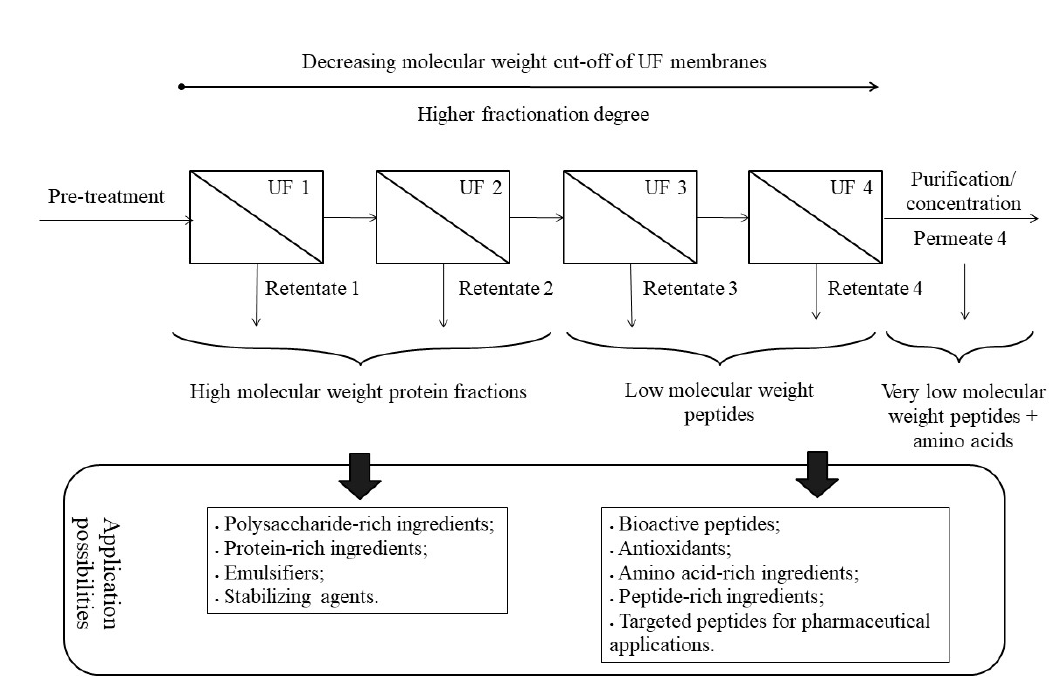
Figure 2. Ultrafiltration (UF) fractionation cascades for the recovery of several protein and peptides-based ingredients, using 500–1 kg mol − 1 molecular weight cut-off